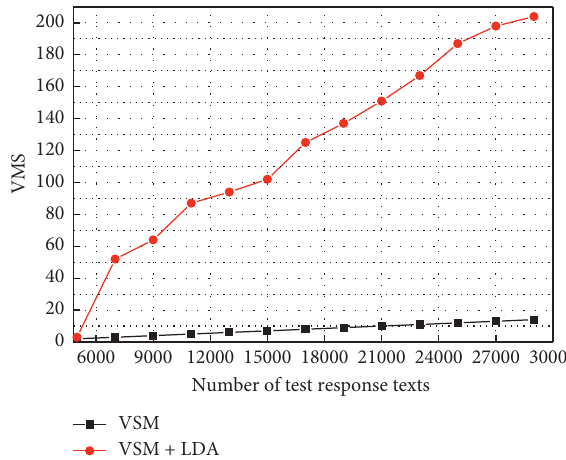
Figure 3: Increasing the number of feature phrases to test the running